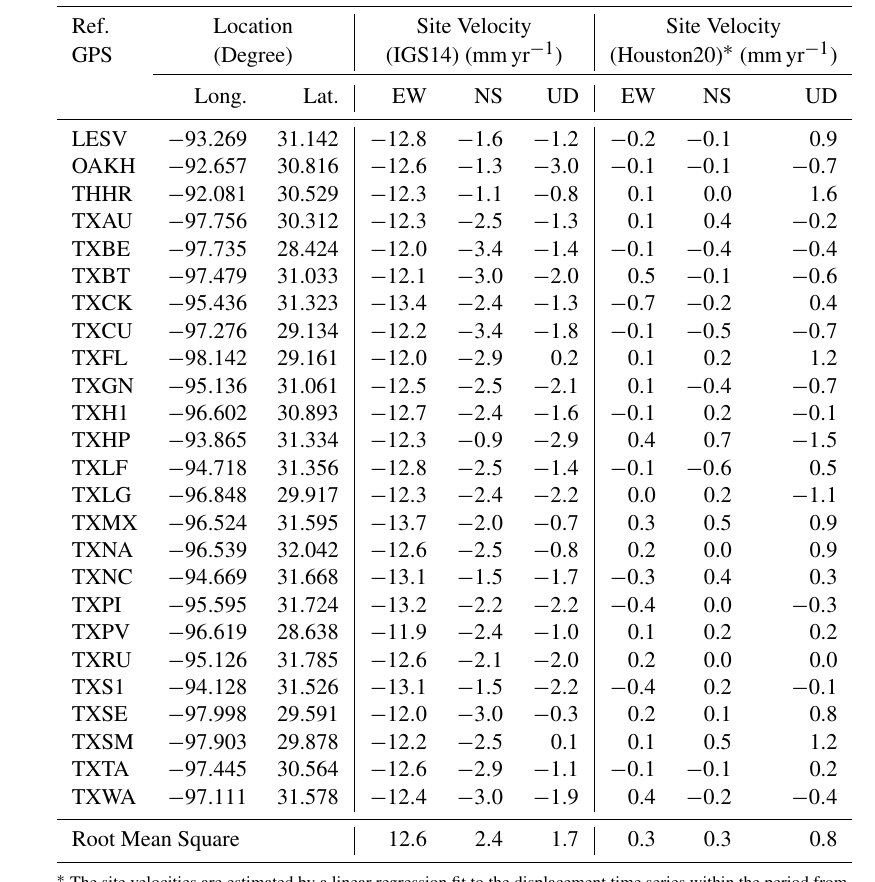
Table 1. Site velocities of 25 reference stations.